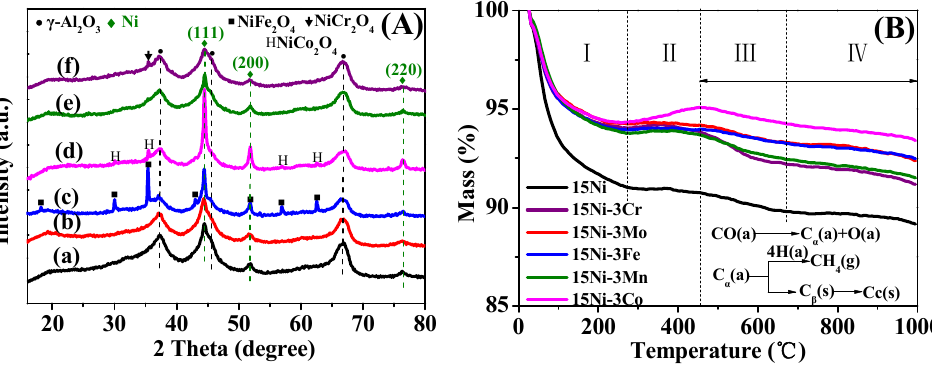
Figure 6. XRD patterns ( A ) and TG curves ( B ) of spent catalysts after performance tests: (a) 15Ni, (b) 15Ni-3Mo, (c) 15Ni-3Fe, (d) 15Ni-3Co, (e) 15Ni-3Mn and (f) 15Ni-3Cr.